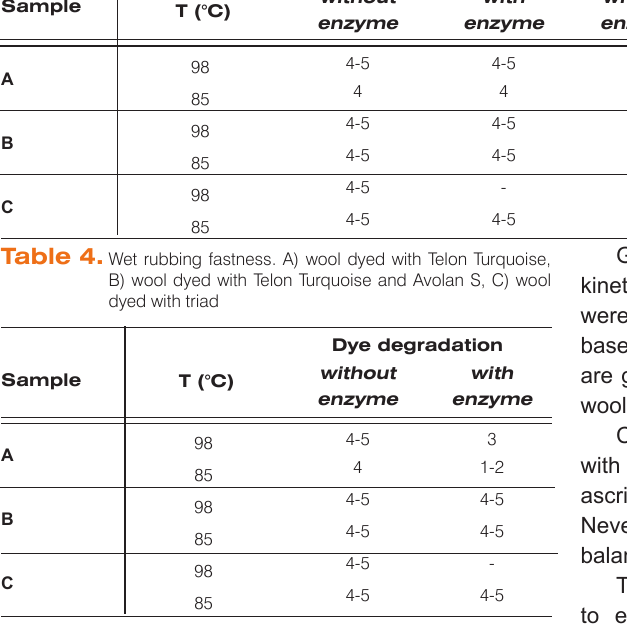
Table 3. Acid perspiration fastness. A) wool dyed with Telon Turquoise, B) wool dyed with Telon Turquoise and Avolan S, C) wool dyed with triad Dye degradation Staining on wool Staining on cotton